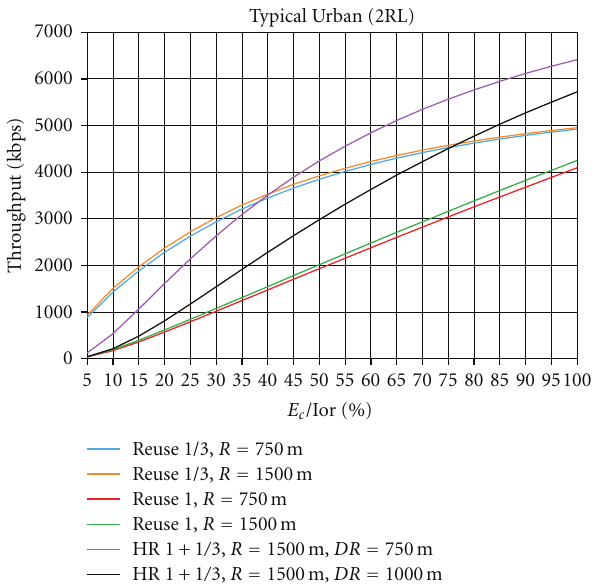
codes and is smaller than with higher coding